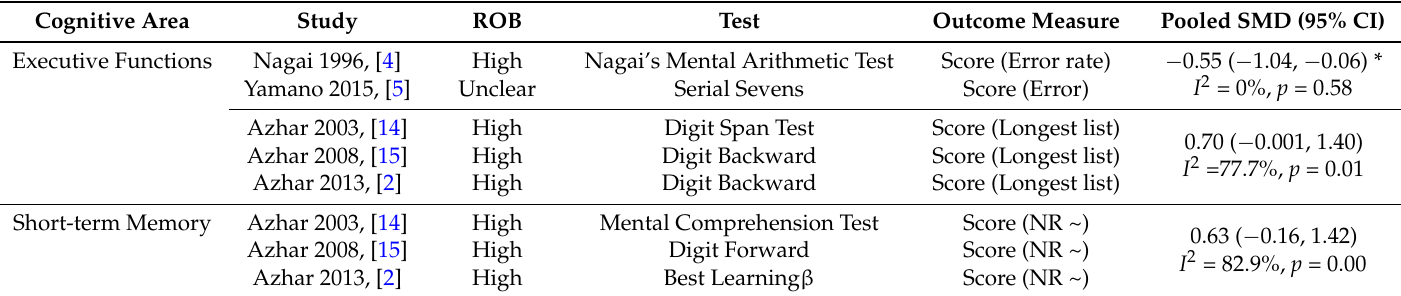
Table 5. Pooled results of meta-analysis using a random-effects